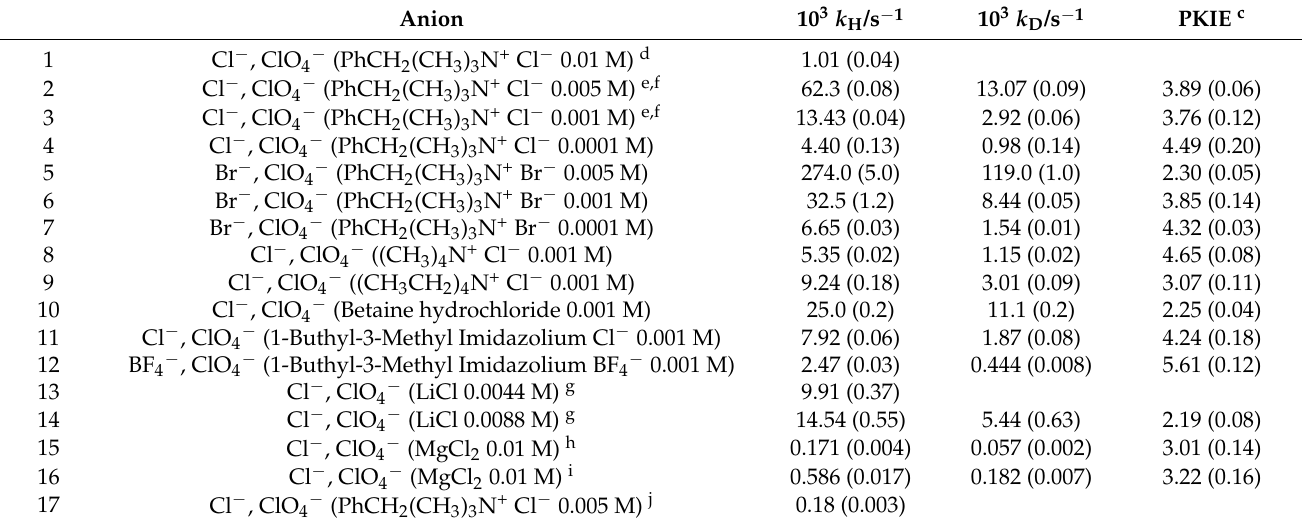
Table 2. Influence of the anions on the observed rate constants and kinetic isotope effects in the reaction of aldehydes and nitrosobenzene a,b .